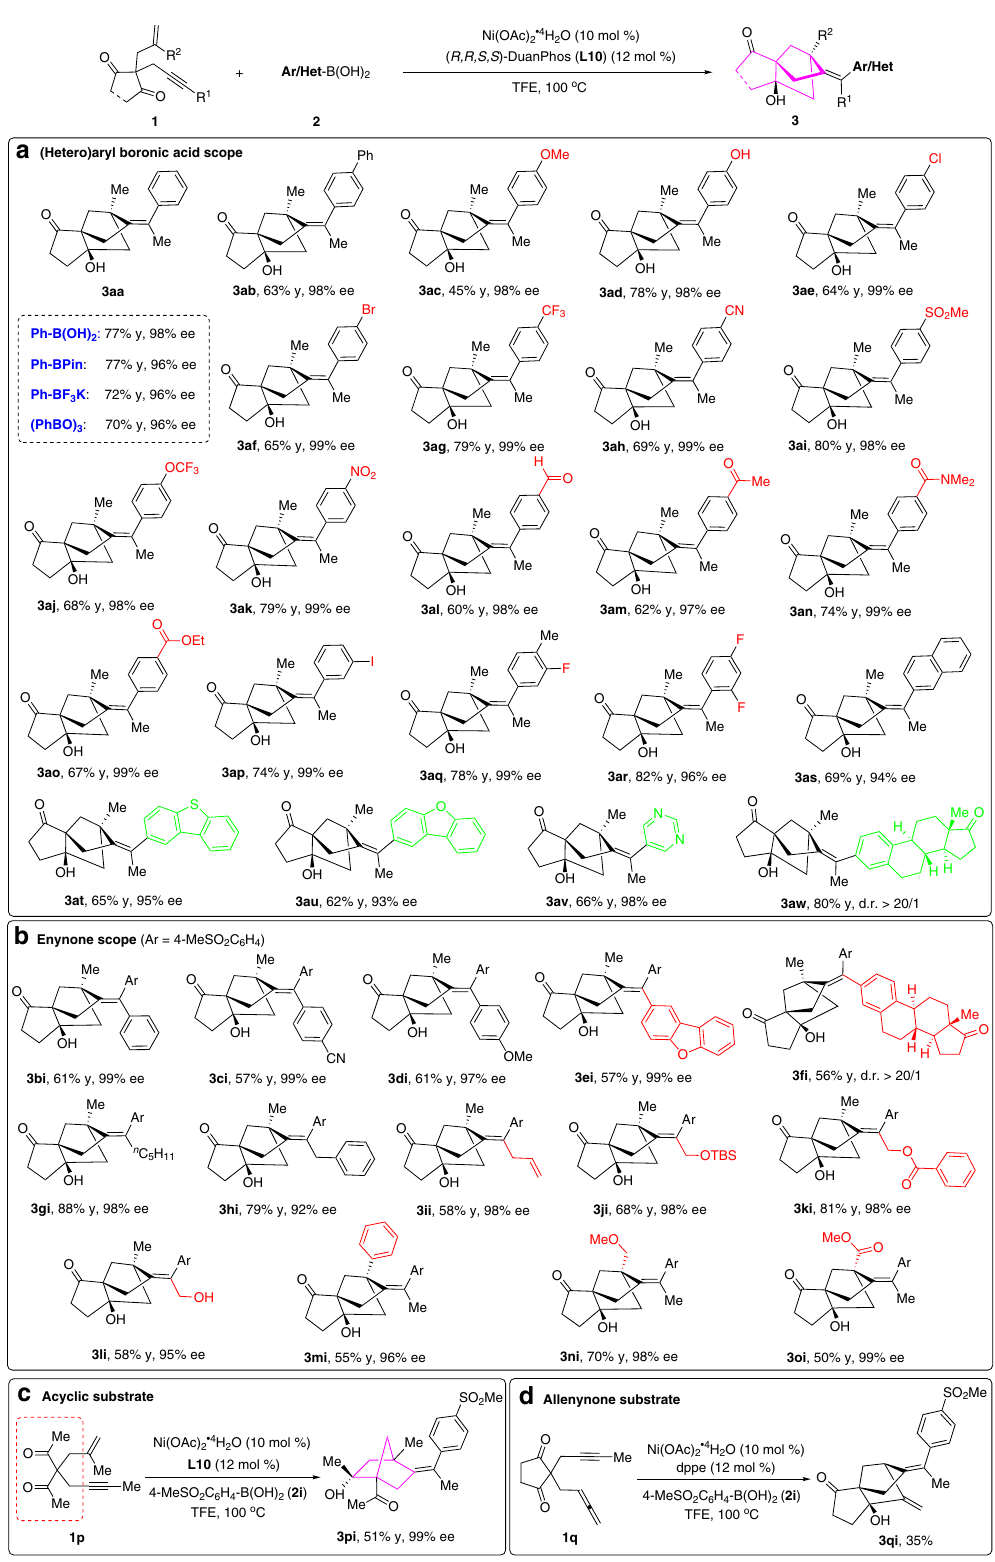
Fig. 4 Substrate scope. a (Hetero)arylboronic acid scope. b Enynone scope. c Acyclic substrate. d Allenynone